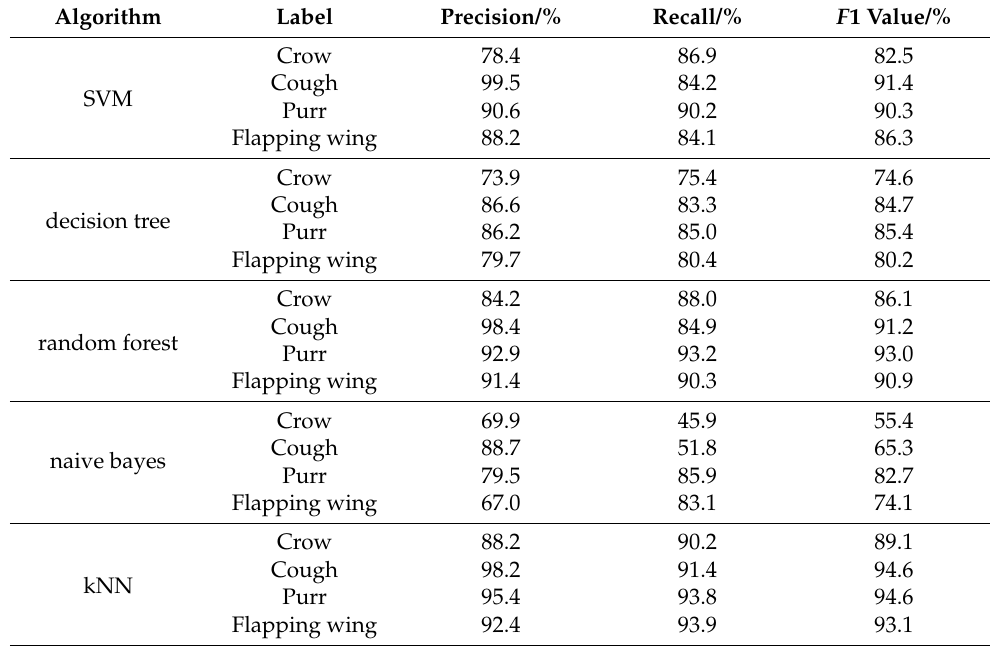
Table 7. Other performance evaluation indexes obtained by five classification algorithms.